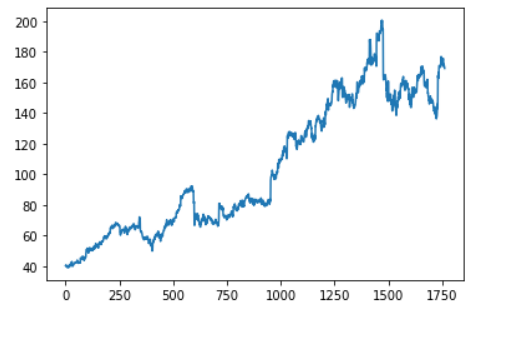
Figure 9. Data Converted to Time-series